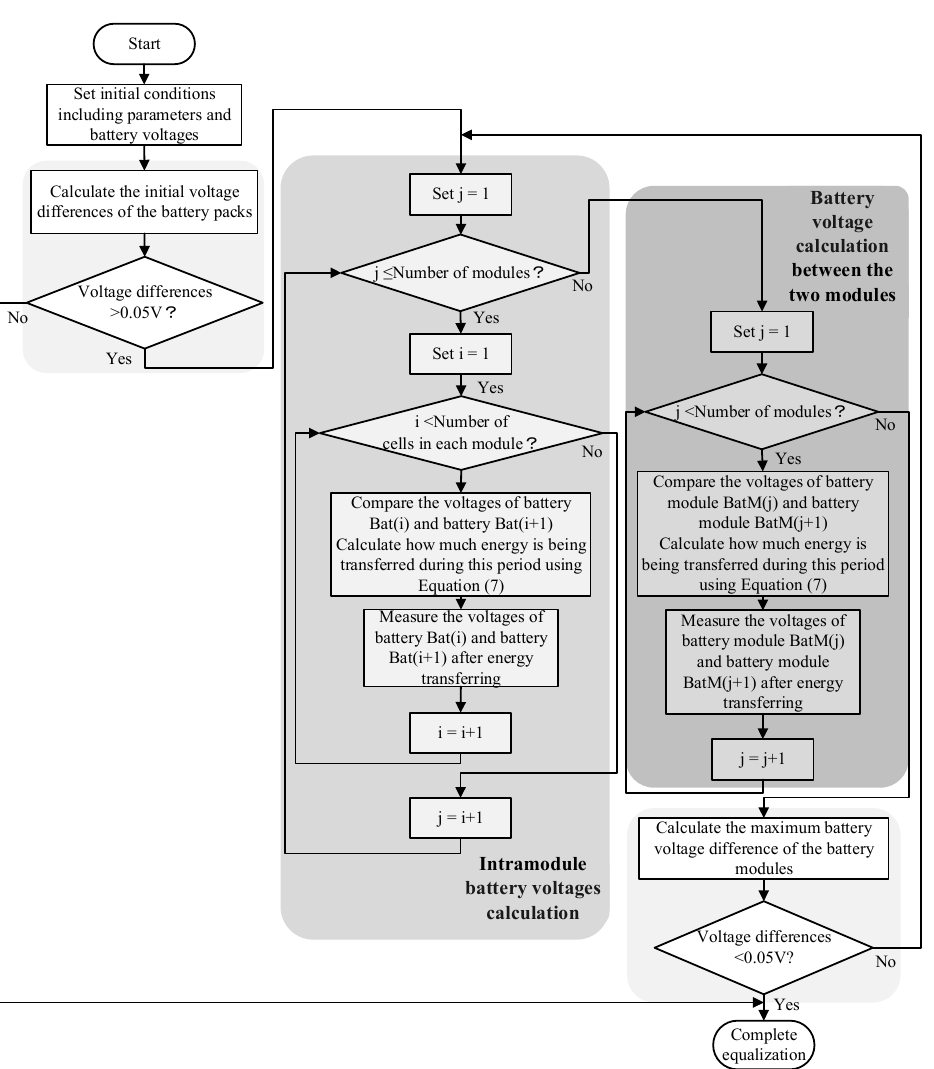
Figure 12. Flowchart of the modularized SC-based